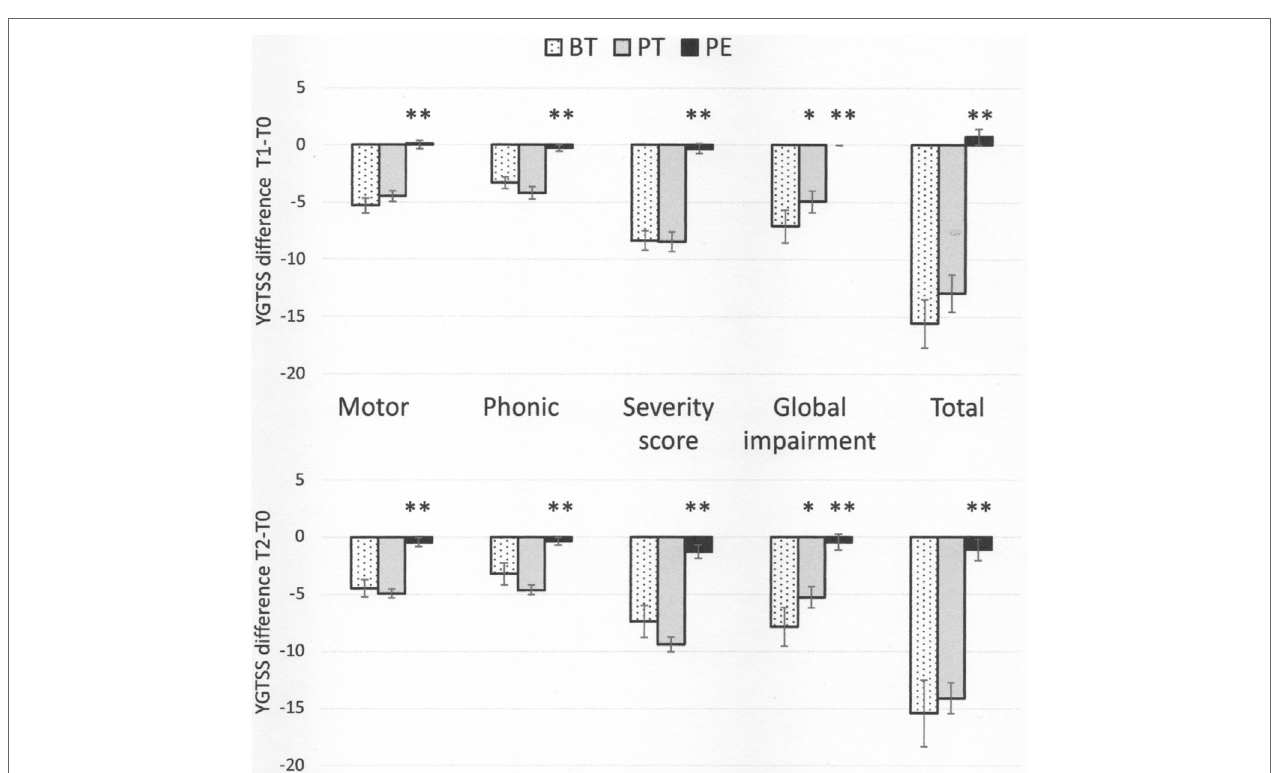
FigUre 1 | Yale Global Tic Severity Scale score variations (means and SEs) from baseline (T0) to time 1 (Tl) and 2 (T2) * p < 0.05, behavioral therapy (BT) vs pharmacotherapy (PT); ** p < 0.01, psychoeducation vs both BT and PT.